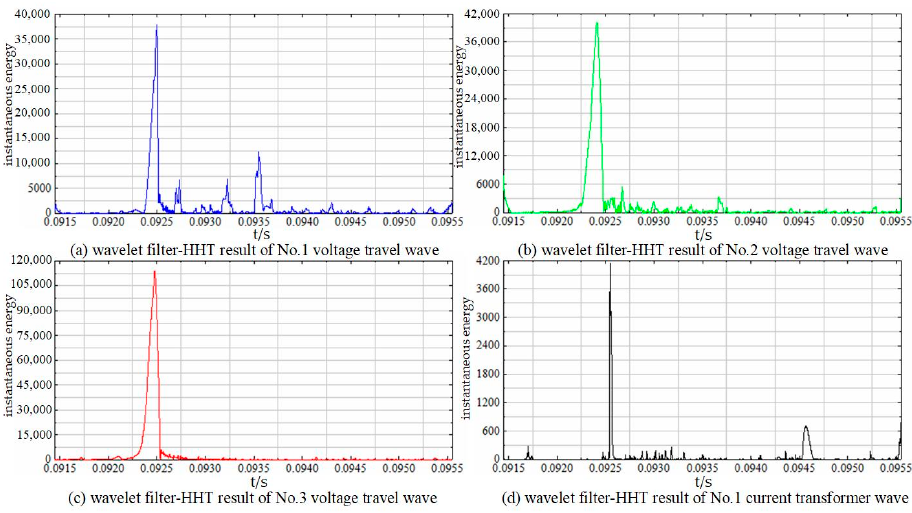
Figure A5. Results of wavelet filter HHT transform in condition 2.